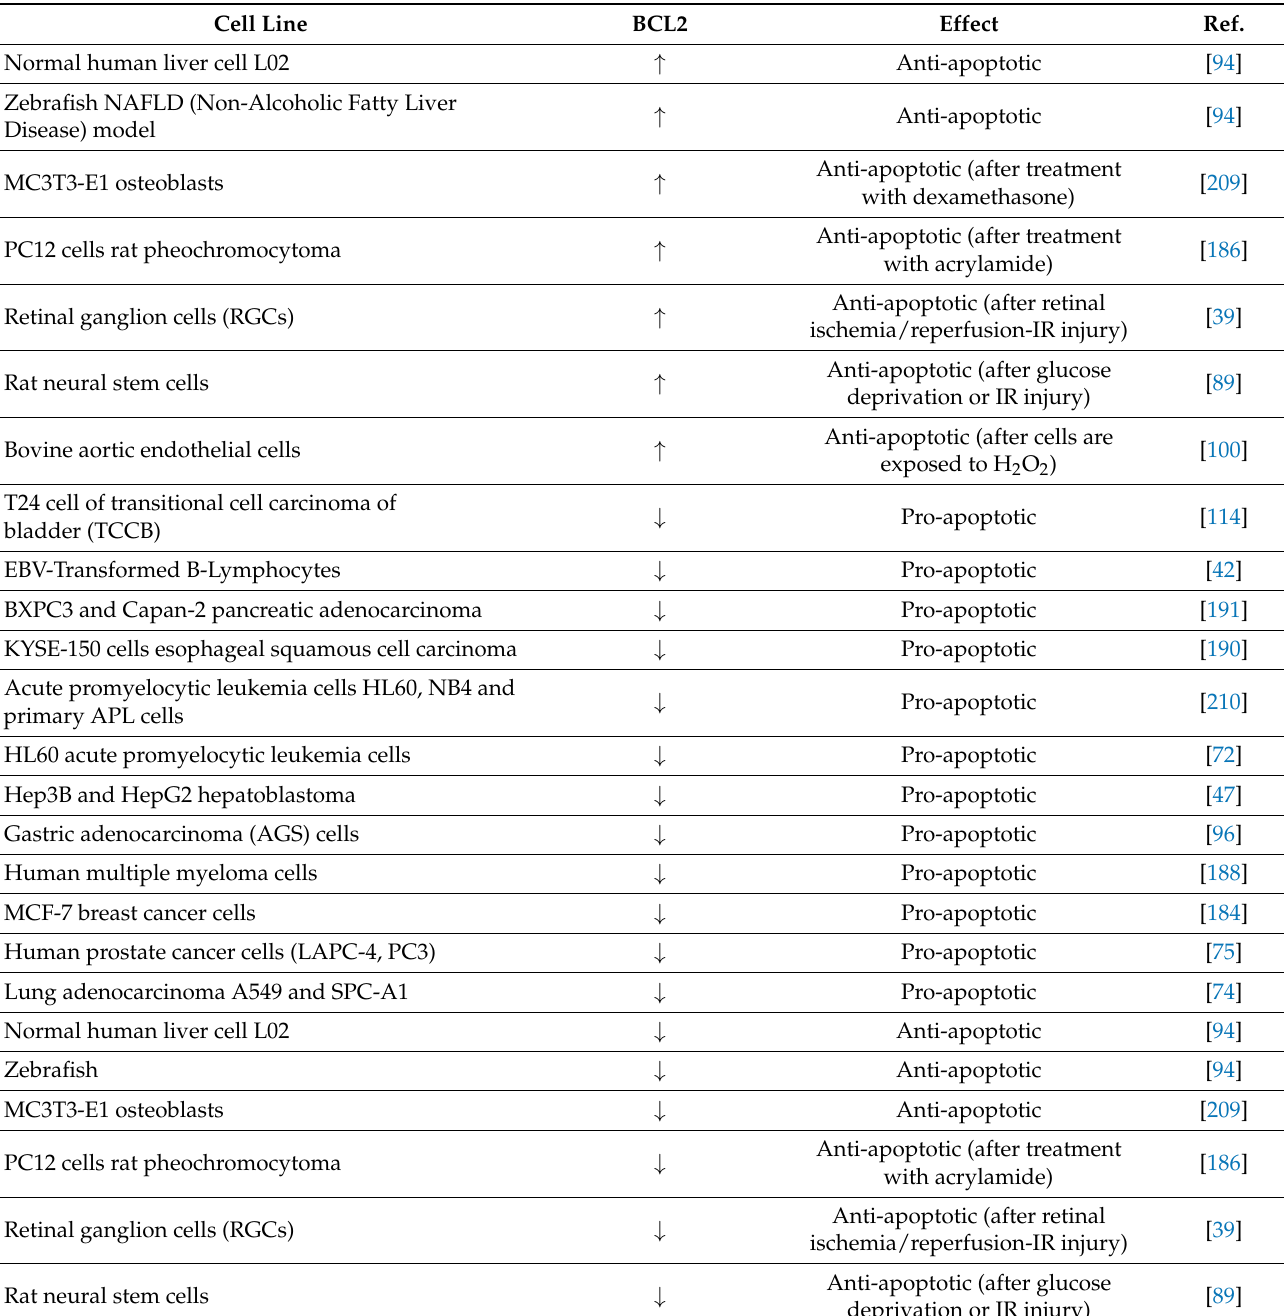
Table 3. Summary of the effects of CRCs and CRT on BCL2 and BAX gene expression. Cell